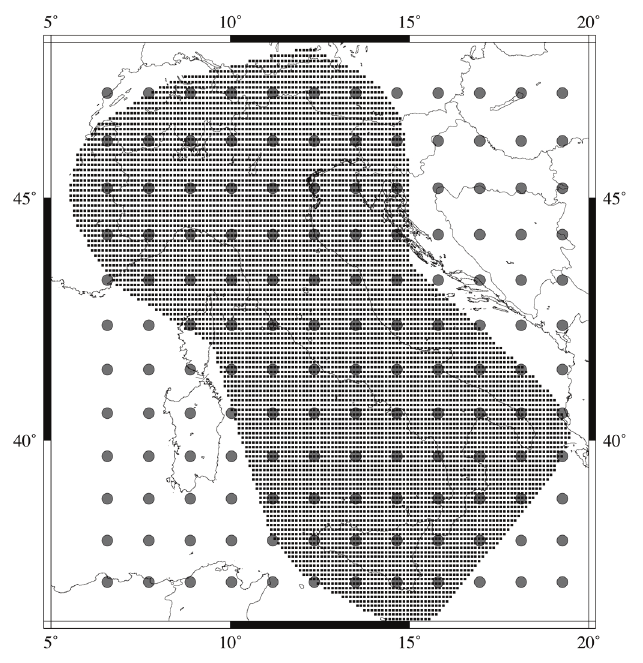
Figure 1. The 169 nodes of the regular grid (light gray circles), and the denser CSEP testing grid (dark gray